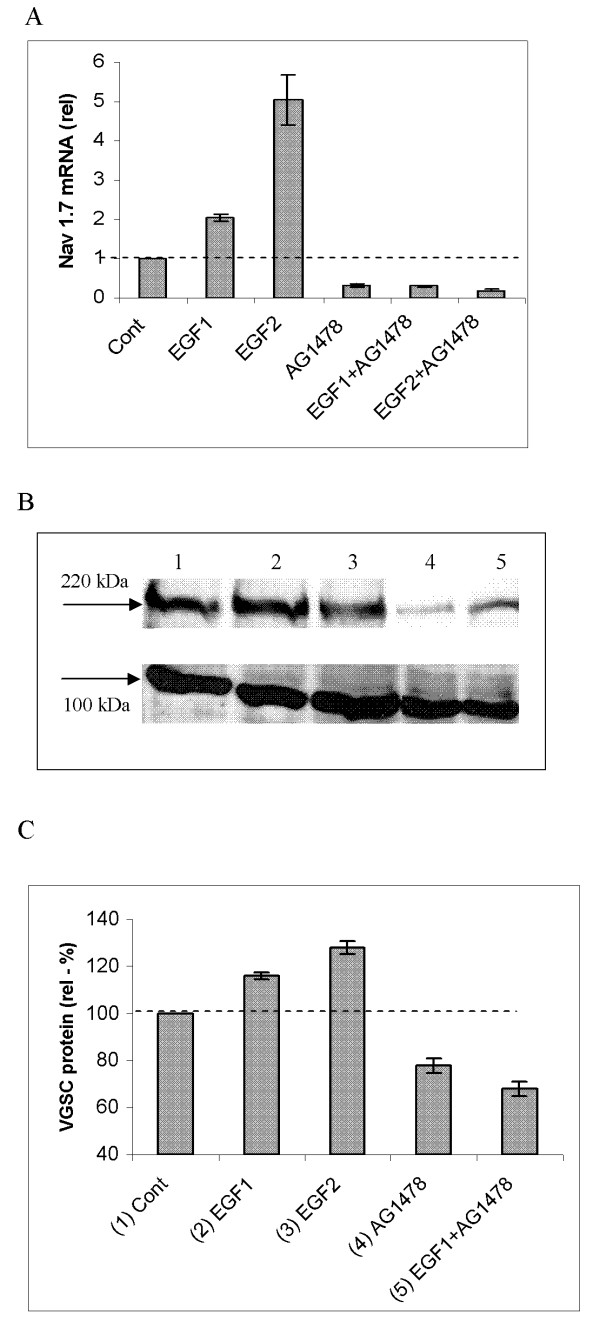
Effects of EGF on VGSC mRNA and protein expression in PC-3M cells. (A) Real-time PCR measurements of Nav1.7 mRNA expression. Data are plotted as fold-differences relative to the control (Cont) level (dotted line). All treatments were for 24 hours. Treatments were as follows: EGF1 (50 ng/ml), EGF2 (100 ng/ml), AG1478 (100 nM), and EGF1/2+AG1478. EGF significantly enhanced mRNA expression, and this was suppressed by co-treatment with AG1478 (100 nM). (B) A typical Western blot of effects on total VGSC protein expression (50 μg of protein per lane) over 24 h, with pan-VGSCα and anti-actinin antibodies. Arrows indicate molecular weights of ~220 kDa (for VGSCα) and ~100 kDa (for actinin). The lanes denote the following: 1) Control (Cont.; cells in 0.5 % FBS); (2) EGF1 (50 ng/ml); (3) EGF2 (100 ng/ml); (4) AG1478 (100 nM); and (5) EGF1 + AG1478. (C) Quantification and averaging of the data shown in (B) with the corresponding conditions (1–5). VGSC protein expression wasquantified from band optical density. Each histobar (in A and C)denotes mean ± standard error (n = 4–6).